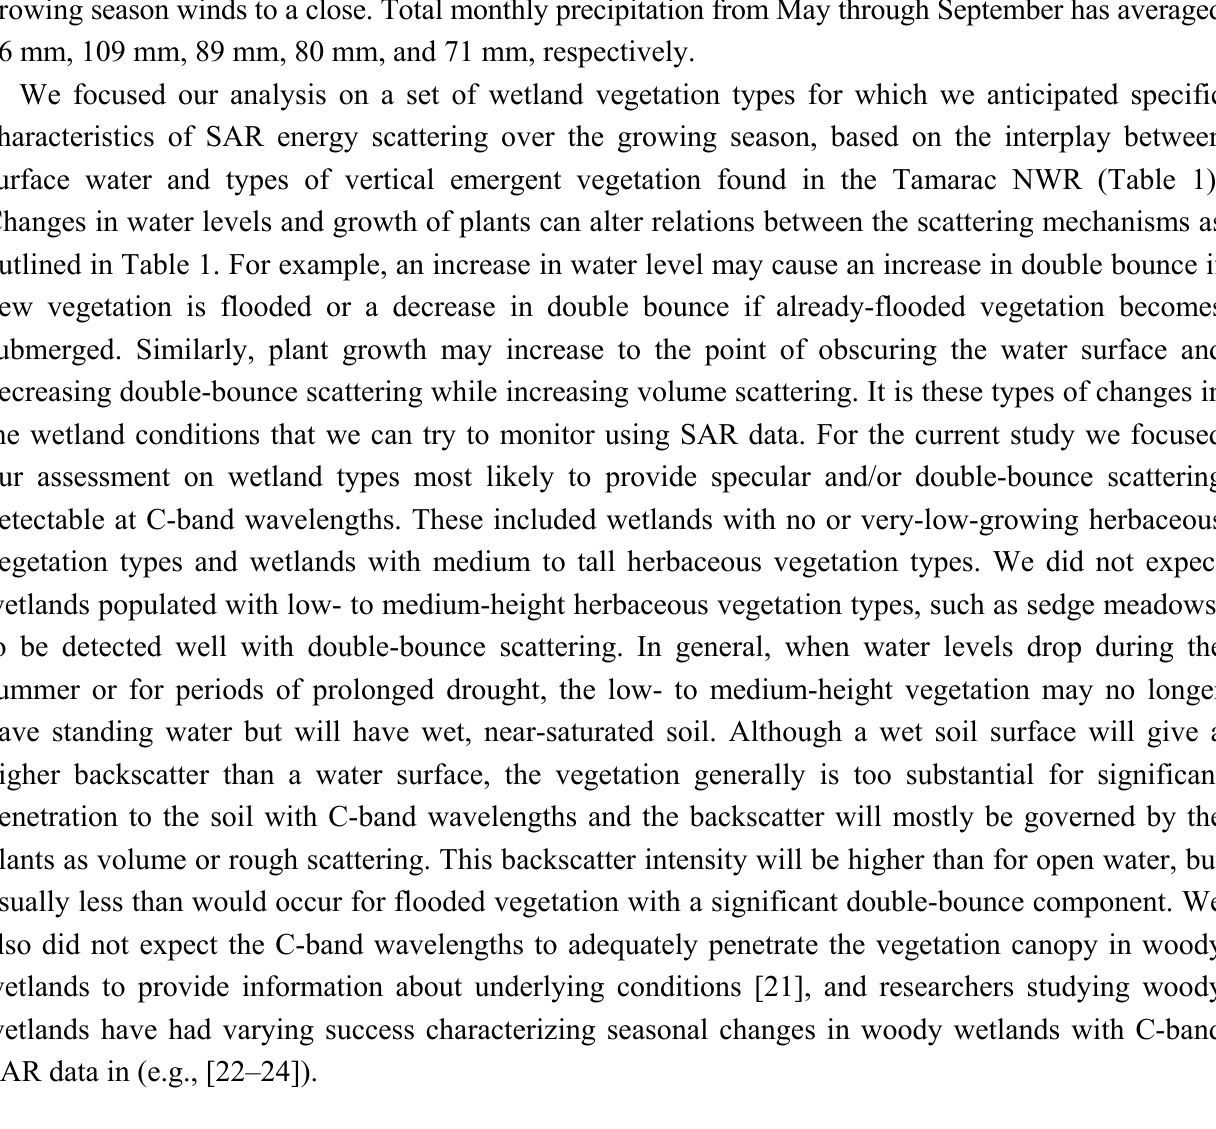
Table 1. General types of wetland vegetation in the Tamarac National Wildlife Refuge and anticipated qualitative energy-scattering characteristics. Note: very-low height is <0.2